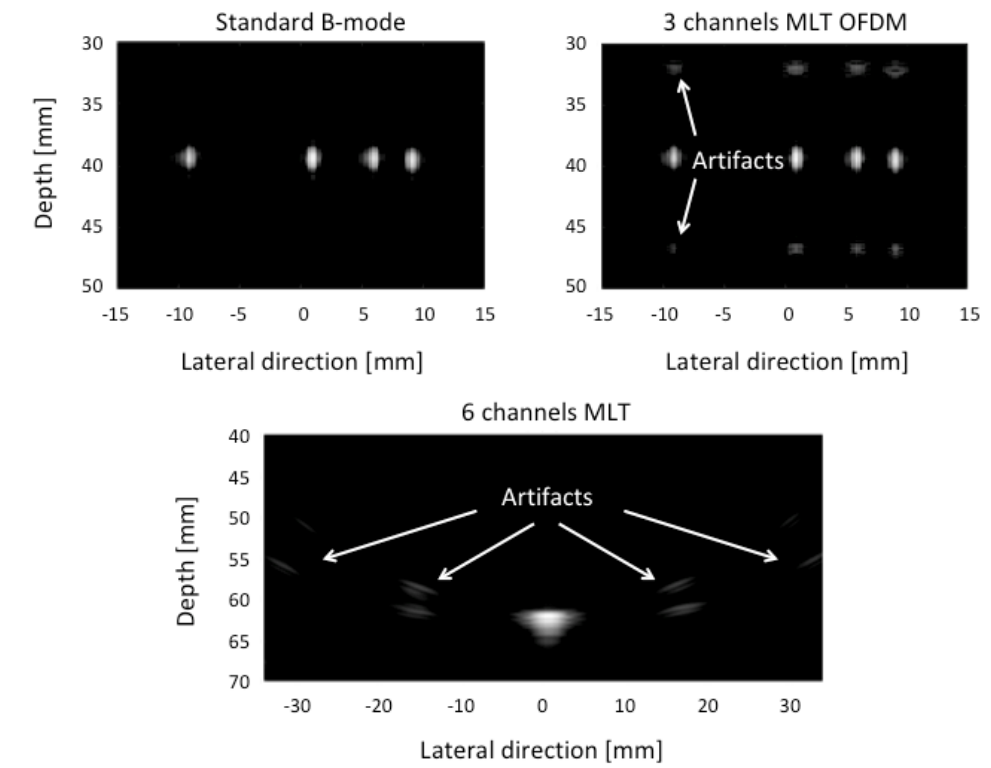
Figure 3. This figure illustrates the effect of inter-beam interference on the image. A standard linear array beam forming image of four wires is shown on the top left corner. The same wires are then imaged with multi-line transmission (MLT) performed by frequency division multiplexing, and applied to linear array beam forming. The corresponding image is shown in the top right corner, and “ghost” wires are clearly visible before and after each wire. At the bottom, an image of a single wire obtained with MLT performed without frequency division multiplexing, and applied to phased array beam forming, is shown. Also in this case, ghost wires are visible, but at a different position relative to the actual wire.